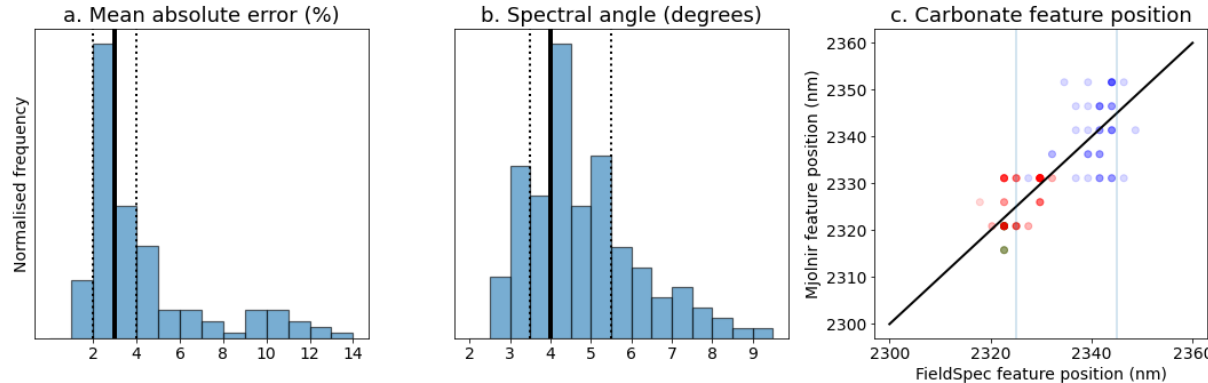
Figure 10. Quantitative error metrics showing the mean absolute error ( a ) and spectral angle ( b ) between the HySpex Mjolnir and corresponding FieldSpec measurements. Vertical black line shows the median error and vertical dotted lines the 25th and 75th percentiles. A comparison of the carbonate absorption position measured using the different instruments is shown in ( c ), and shows that the ~20 nm shift in absorption feature position between calcite and dolomite can be resolved in both datasets, allowing calcitic lithotypes to be distinguished from dolomitic ones (point colour cor- responds to the different stratigraphic units; cf. Figure 9). Vertical blue lines show the expected po- sition for dolomite (2325 nm) and calcite (2345 nm).